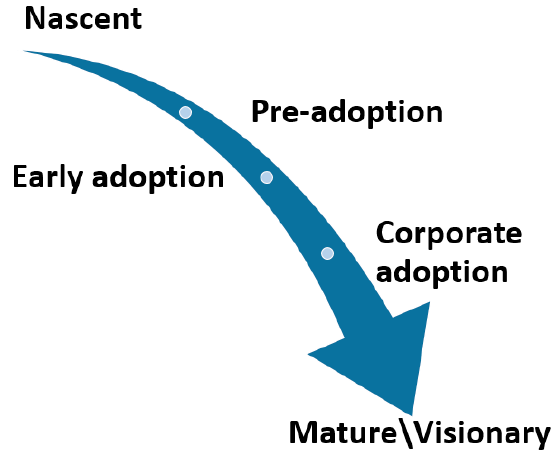
Figure 6. The five stages of the TDWI Maturity Model.